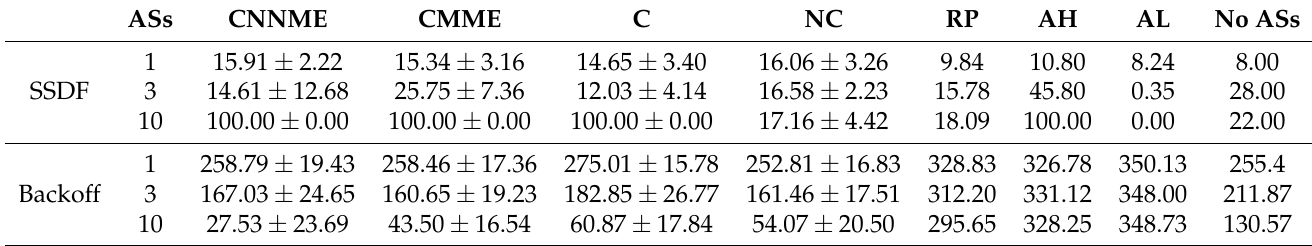
Table 4. Final results in terms of primary detection percentage (SSDF) and kbits that GSs transmit (backoff), obtained for each combination of attack, number of ASs and setup. The values were obtained averaging 50 episodes for the best seed of each attack policy after training. We show the average value ± one standard deviation. Higher is better in SSDF; lower is better in backoff